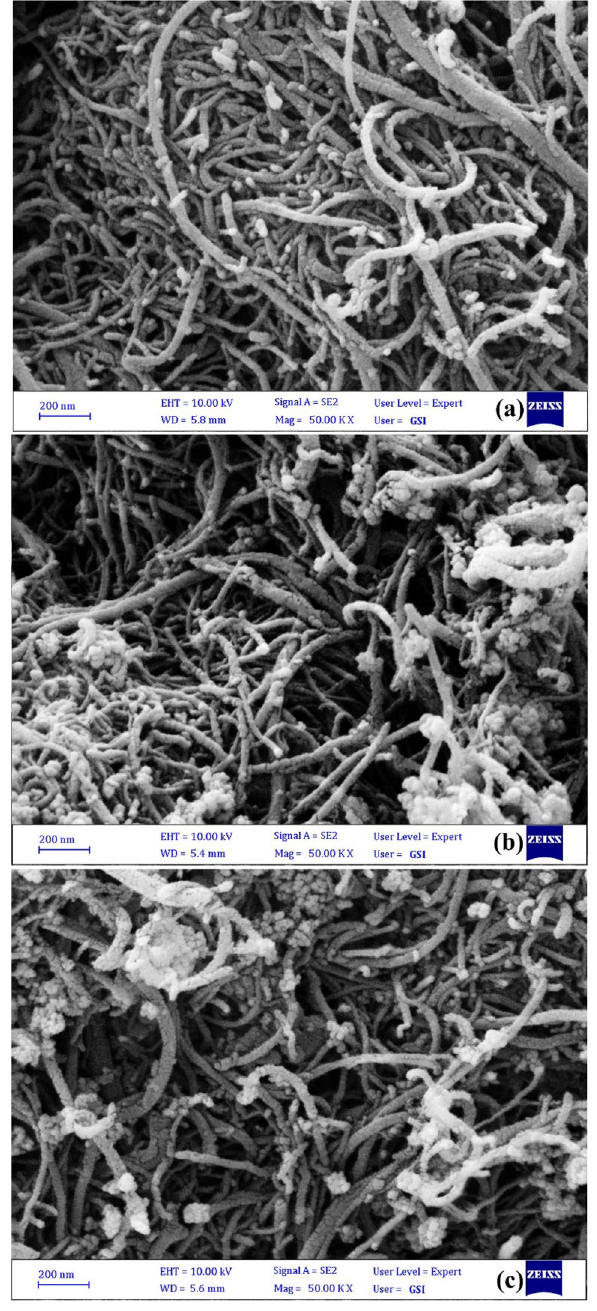
Figure 4. FESEM images of CNT ( a ), CuO-CNT ( b ), and ZnS/CuO-CNT ( c